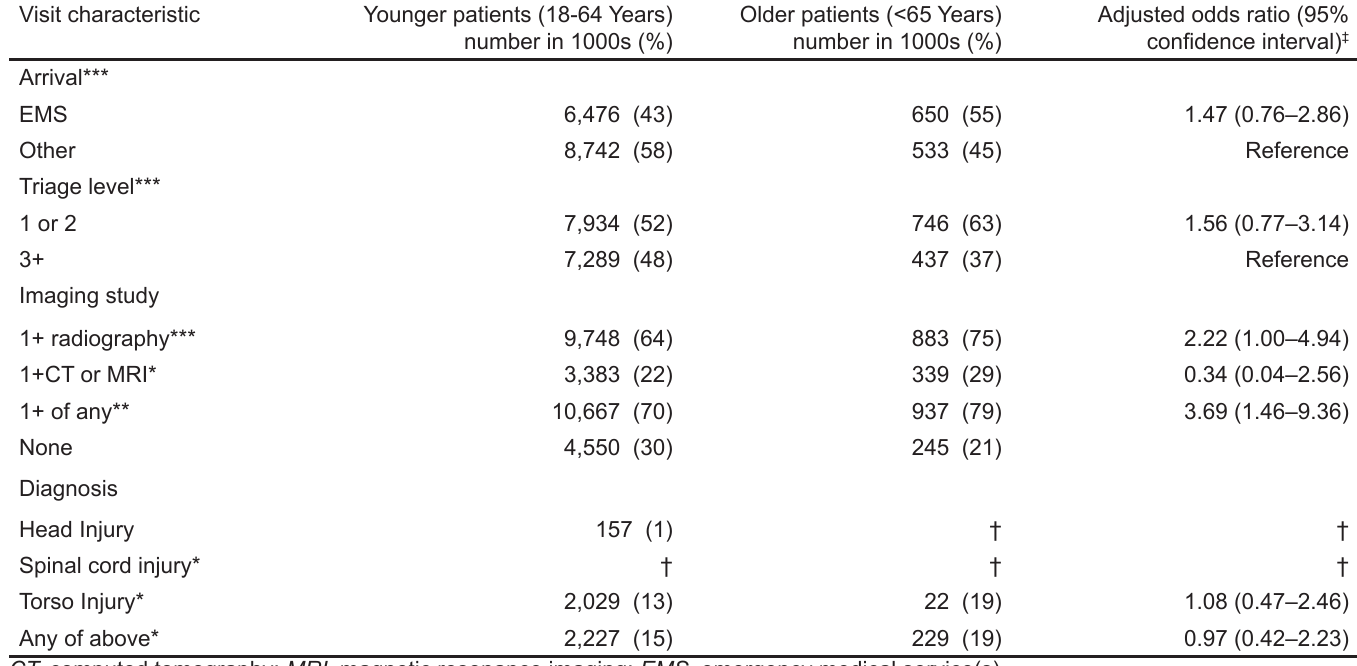
Table 2. Comparison of visit characteristics of motor vehicle crash patients treated in emergency departments by age, United States